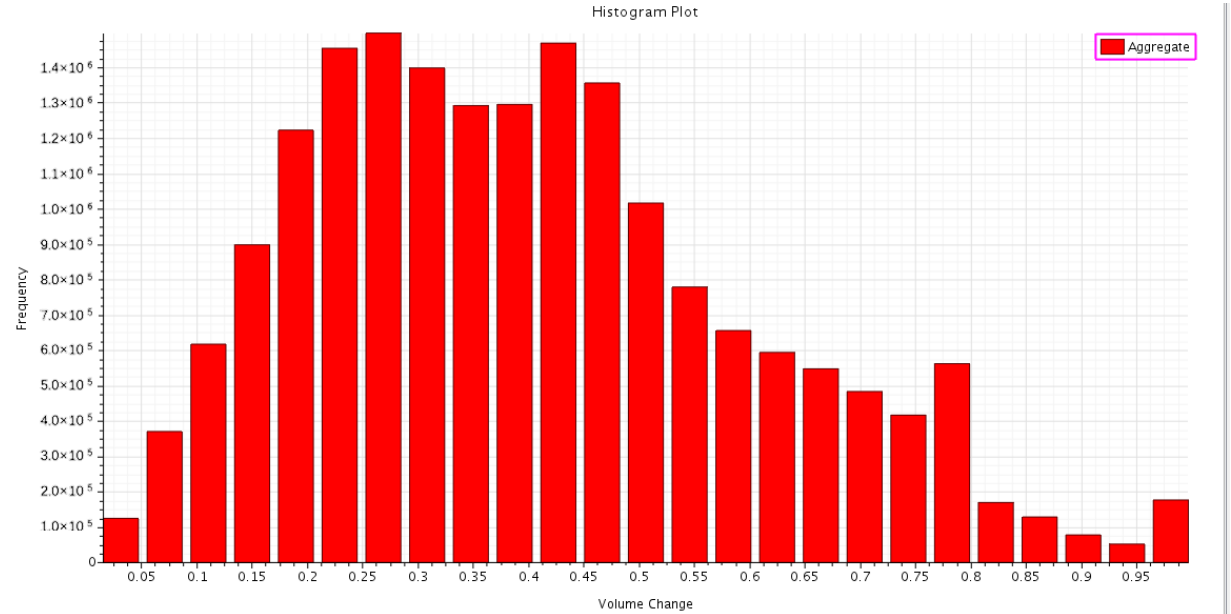
Figure 6. Volume change of mesh unit .